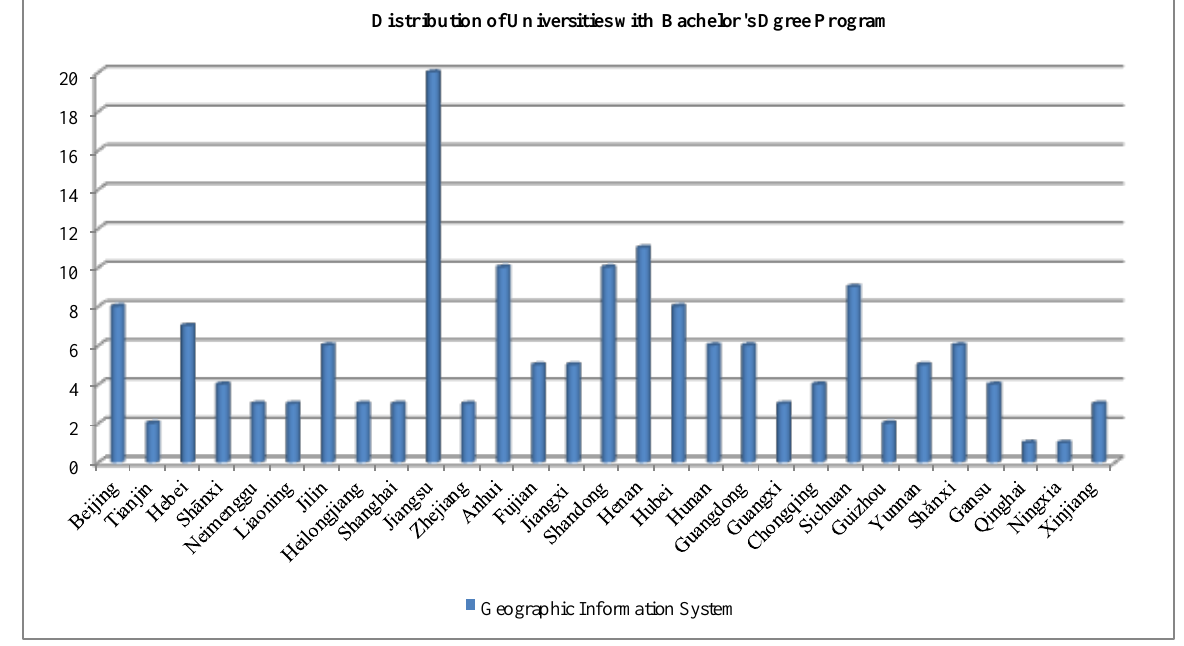
Figure 1. Distribution of Universities with Bachelor’s Degree Program